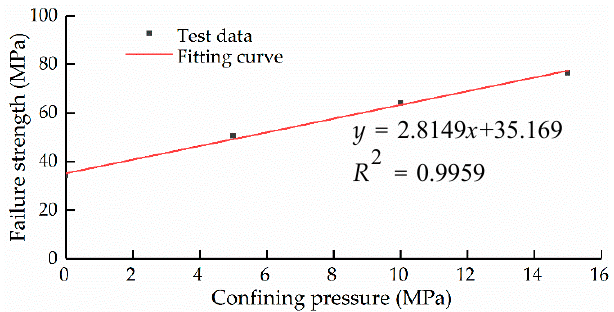
Figure 2. Failure strength and fitting curve under different confining pressures.